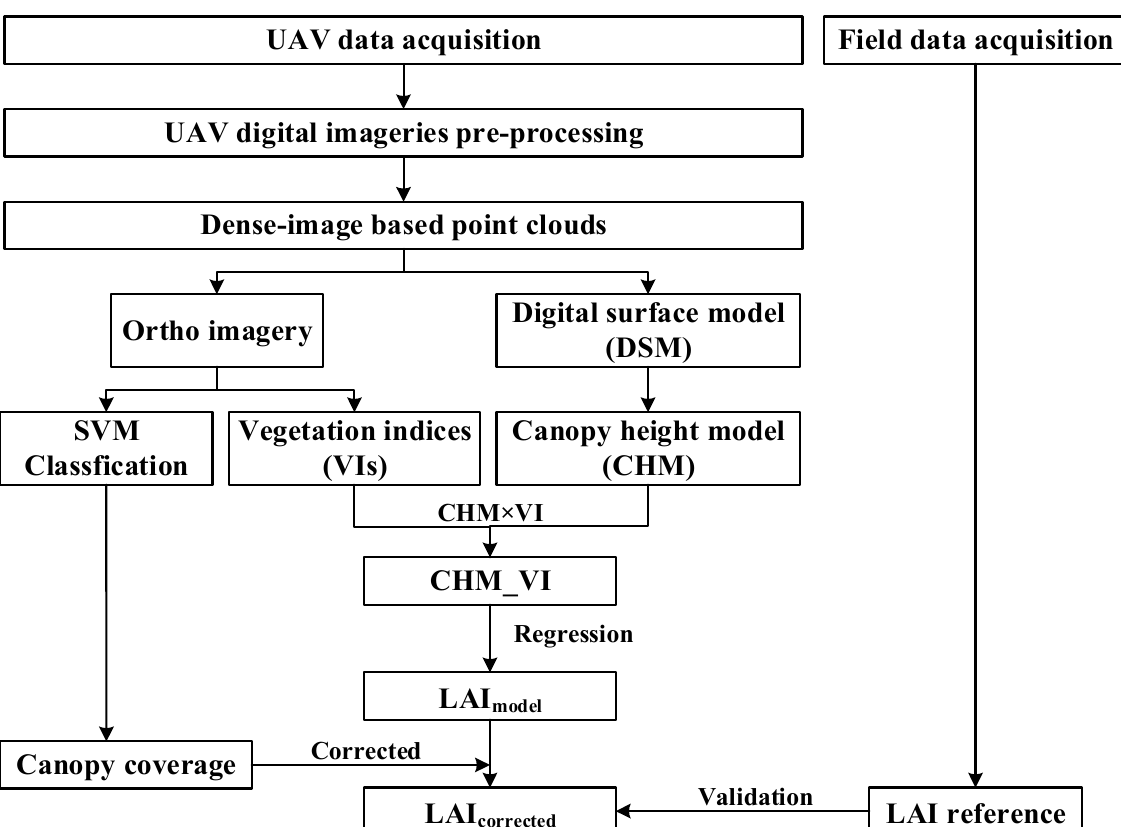
Figure 3. A flowchart outlining the improved LAI estimation method for estimating LAI.